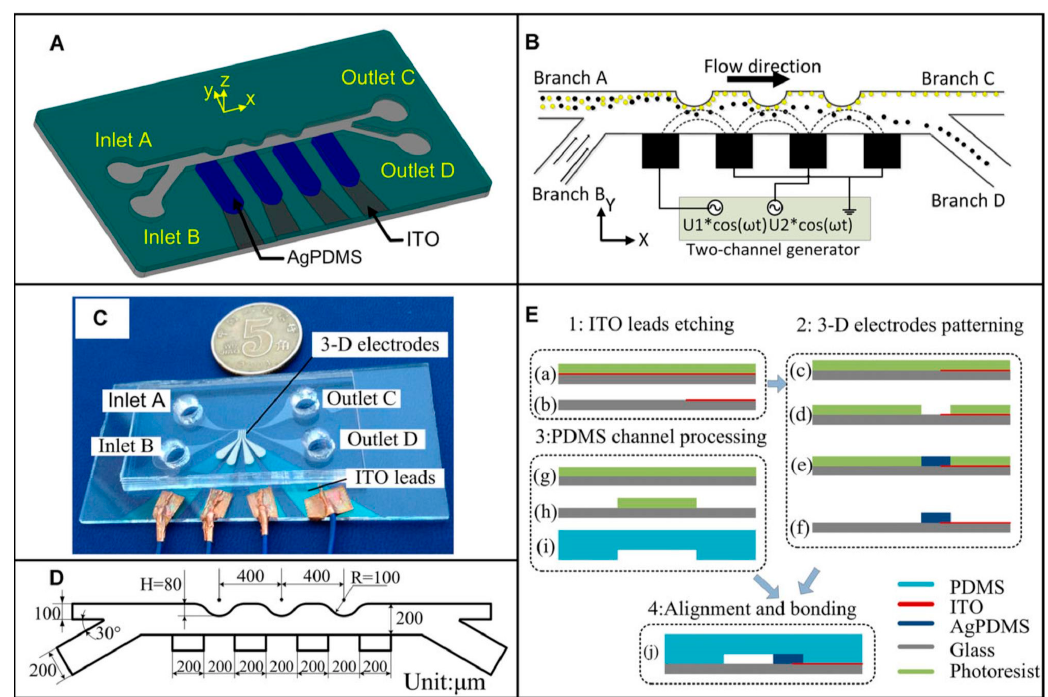
Figure 13. A 3D Ag ‐ polydimethylsiloxane (PDMS) electrode microfluidic device. Reproduced with permission from [89], © 2015 John Wiley and Sons. ( A ) Schematic of the device. ( B ) The drawing of the separation. ( C ) The photo of the device. ( D ) The dimension of the structure. ( E ) The fabrication process of the device.